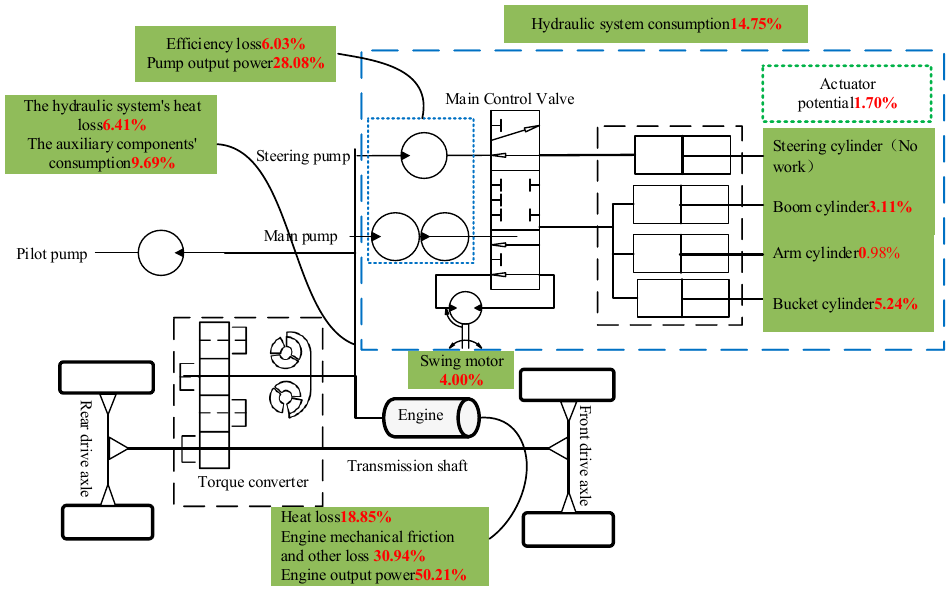
Figure 23. Excavator operation condition energy flow.